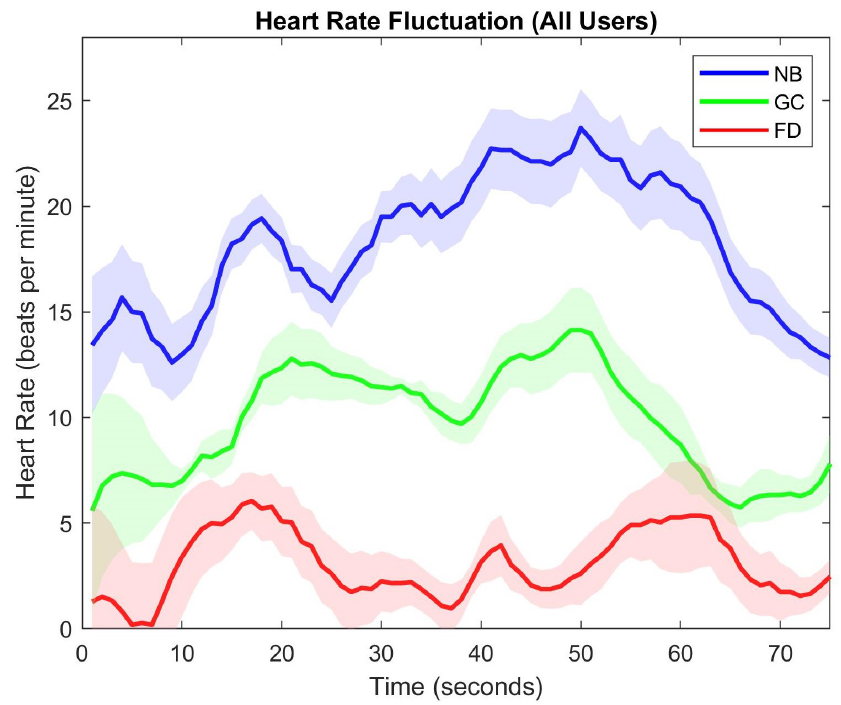
Figure 14. Average heart rate fluctuations from a resting heart rate during a rollercoaster cycle. Origin on the heart rate axis represents the resting heart rate. (conditions: NB—No Blur; GC—Unity Blur; FD—Ours).